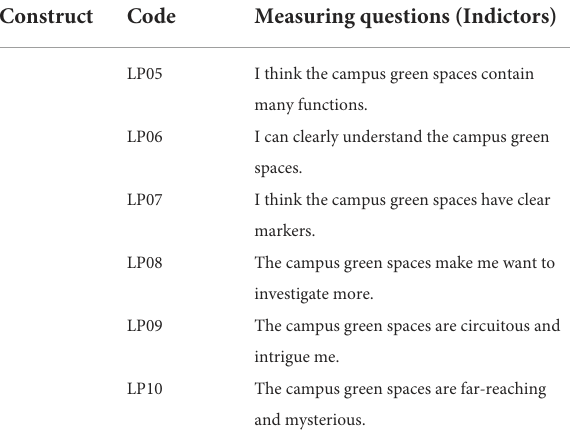
TABLE 1 Latent variables and the corresponding exogenous